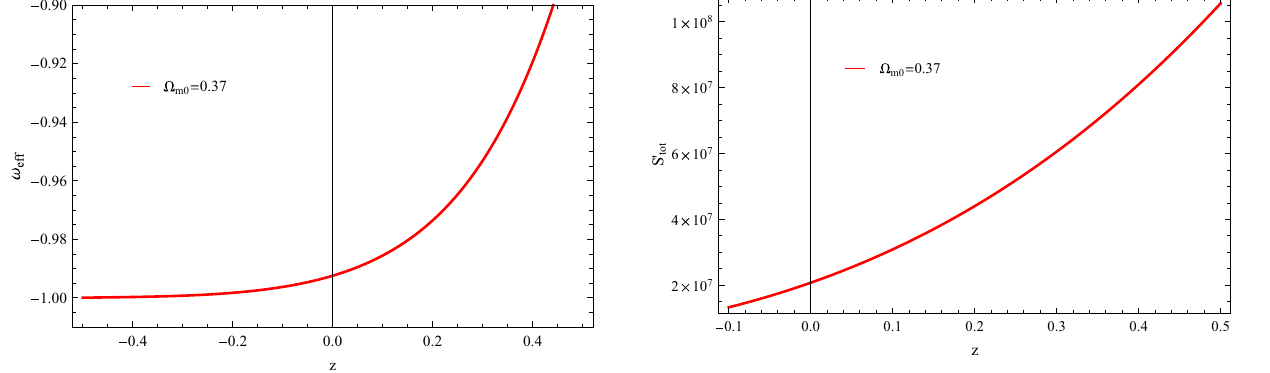
Fig. 15 Plotof S (cid:5) tot versus z atHubblehorizonwithBekensteinentropy